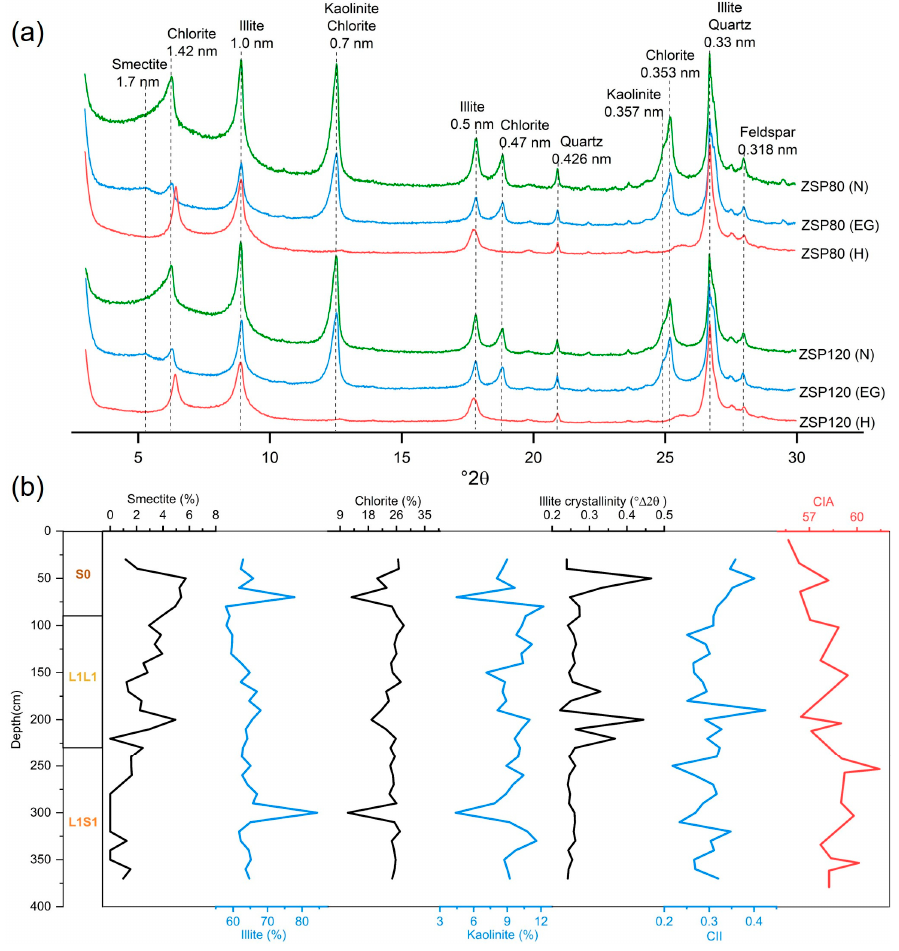
Figure 3. X-ray diffractograms of clay fractions of selected samples ( a ) and relative contents variations of clay minerals with Illite crystallinity, CII (chemical index of illite), and CIA (chemical index of alteration) ( b ) from the ZSP section .